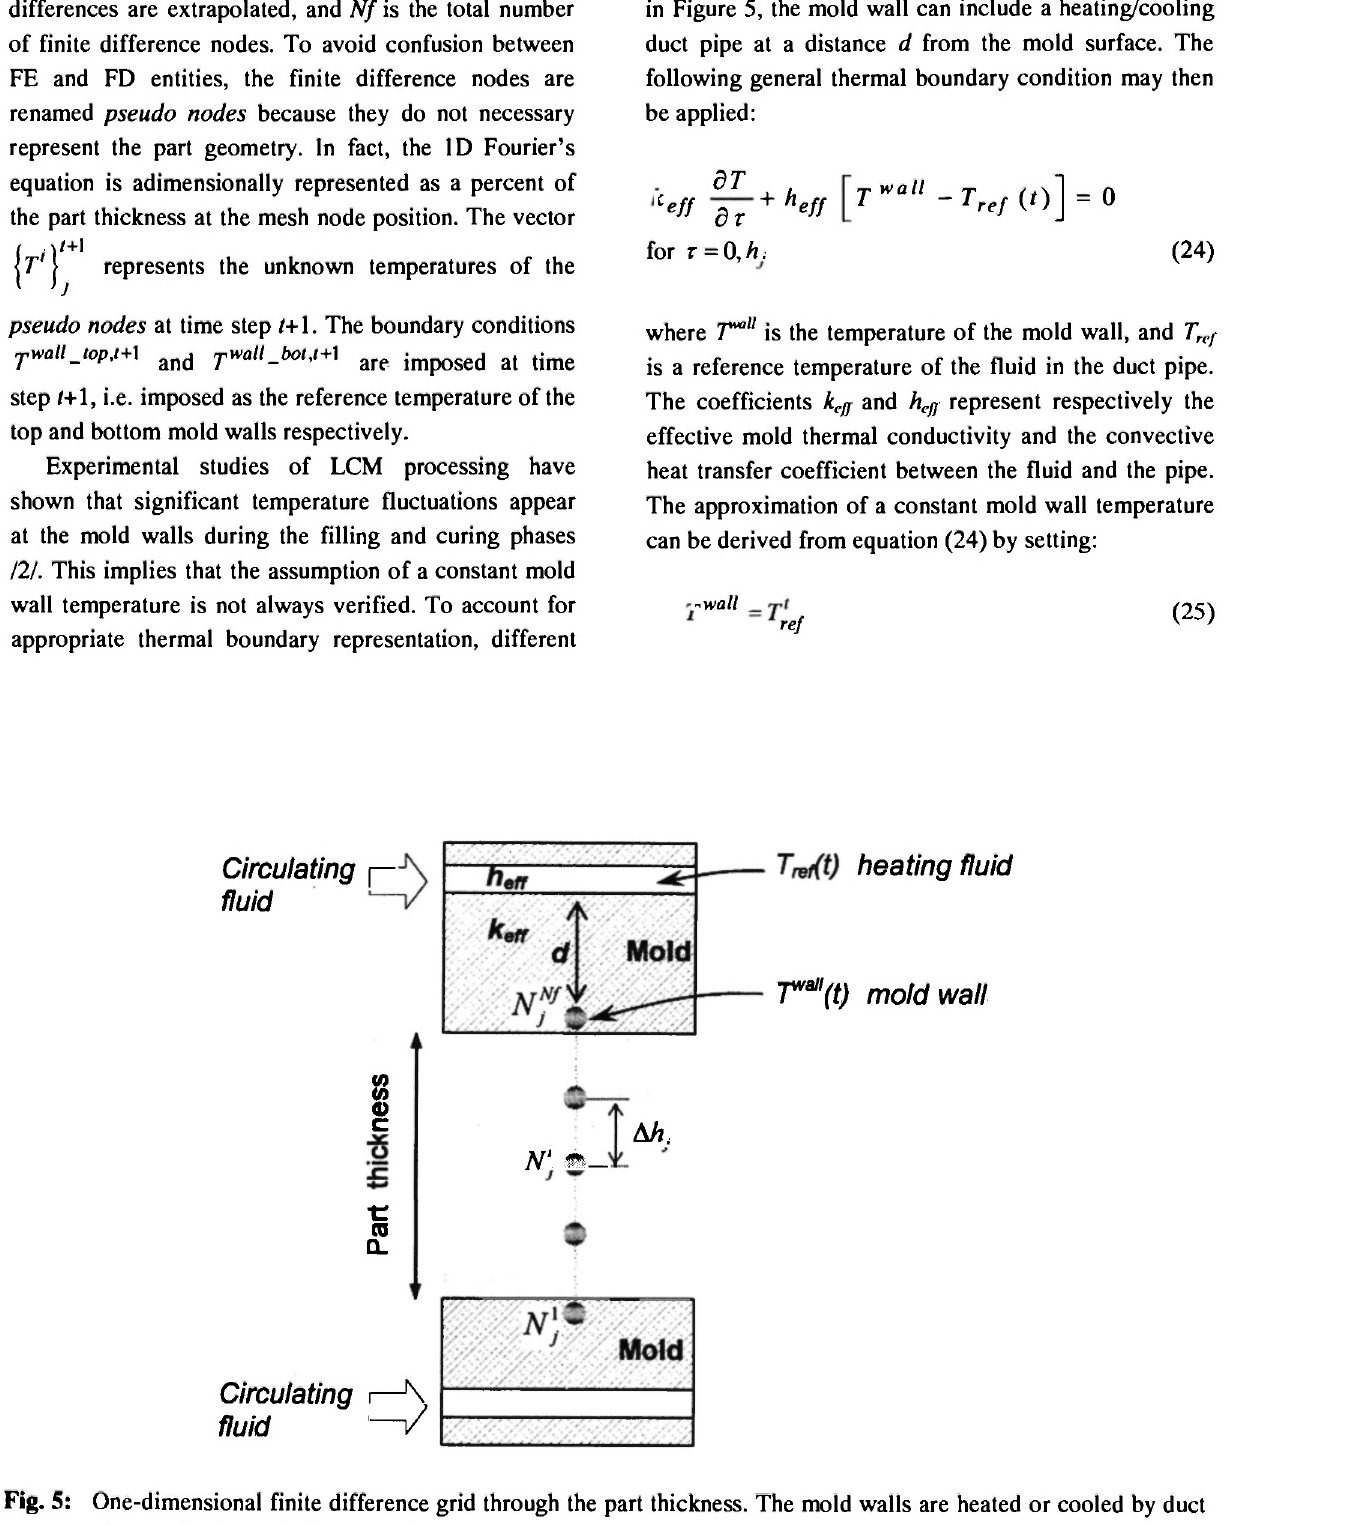
Fig. 5: One-dimensional finite difference grid through the part thickness. The mold walls are heated or cooled by duct pipes maintained at a known reference temperature T rc[